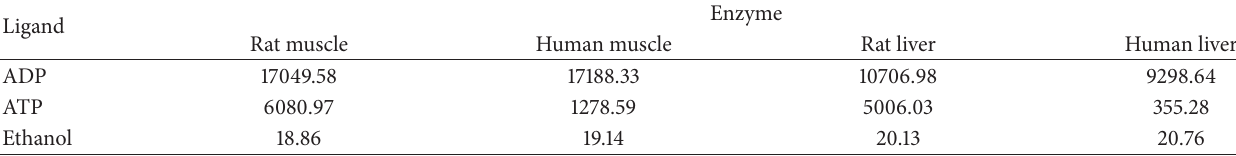
Table 4: Binding constants for ADP, ATP, and ethanol with human and rat muscle and liver phosphofructokinases.